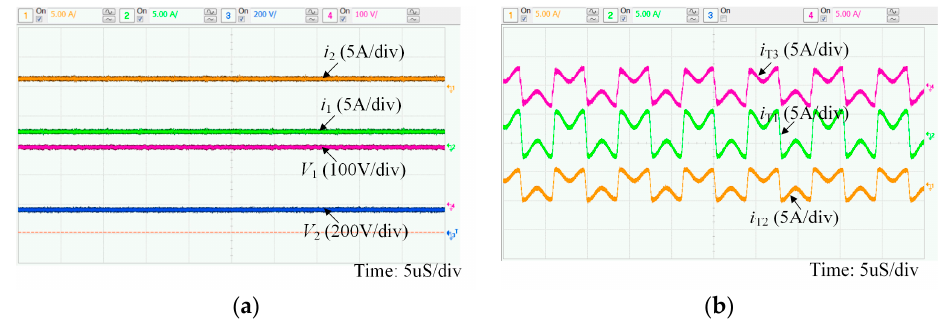
Figure 17. Experimental results of MR-TP-BDC under reverse half load operating mode: ( a ) output